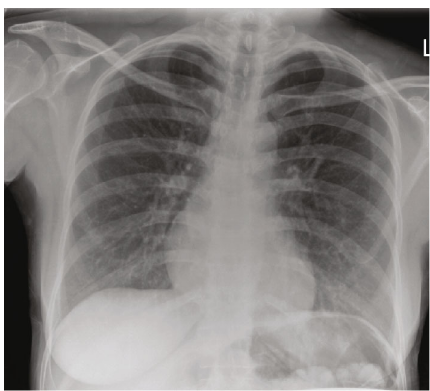
Figure 1: Chest X-ray showing mild bronchial thickening and minimal linear scarring in the left lung base but no de fi nitive focal consolidation, Ghon ’ s focus, or